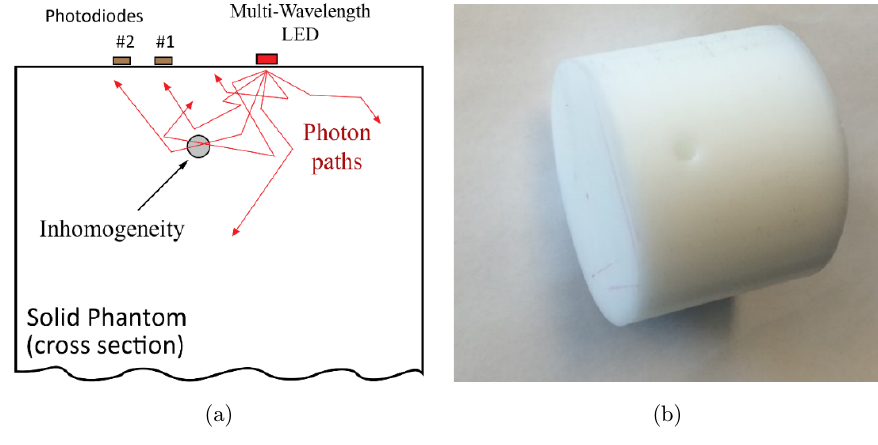
Fig. 4. The breast phantom constructed from acetal resin